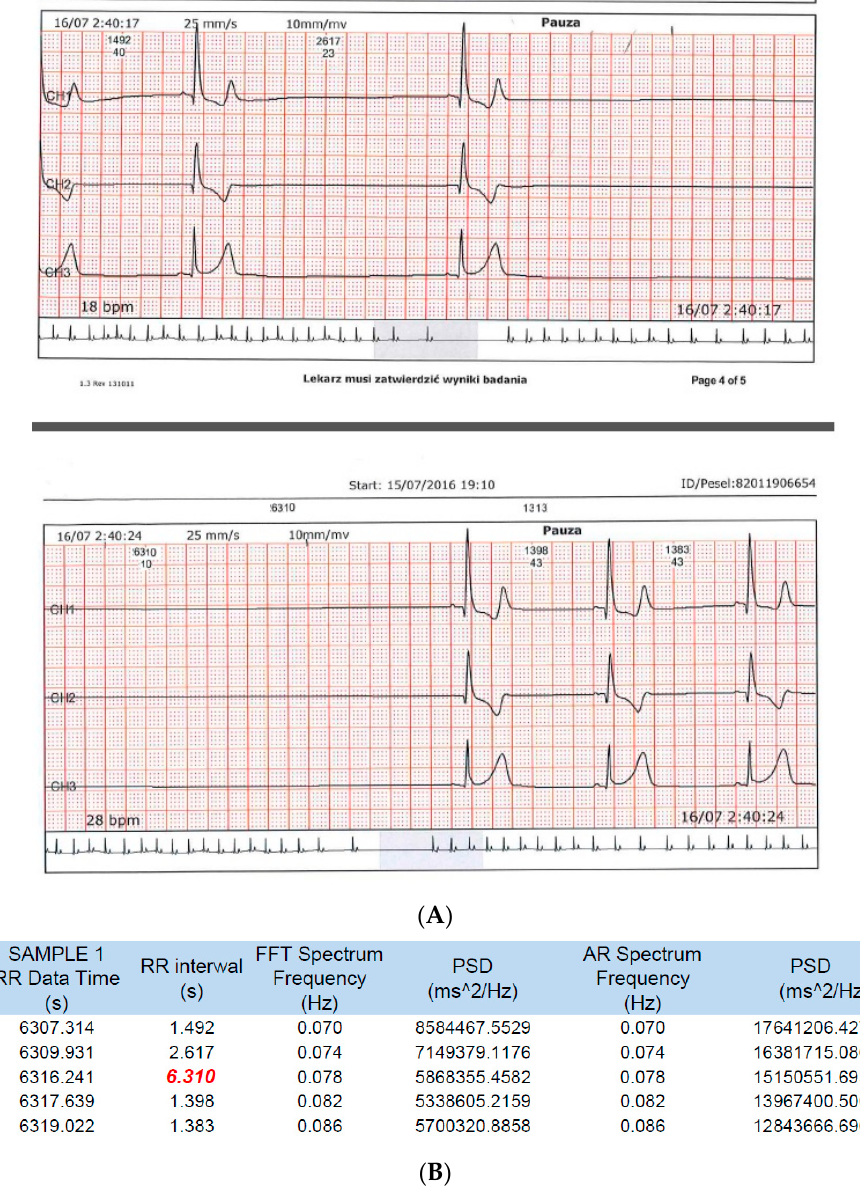
Figure 2. Holter ECG printout ( A ) and the corresponding printout from the HRV function of the HRM ( B ) showing the longest pause recorded on both devices. Red color-the longest pause. The consistency of the recordings of the HRV function of the HRM (Polar V800) in relation to Holter ECG recordings allowed us to consider the maximum R-R interval of 7.3 s, which was recorded only on the HRM, as being a reliable finding (Figure 3).